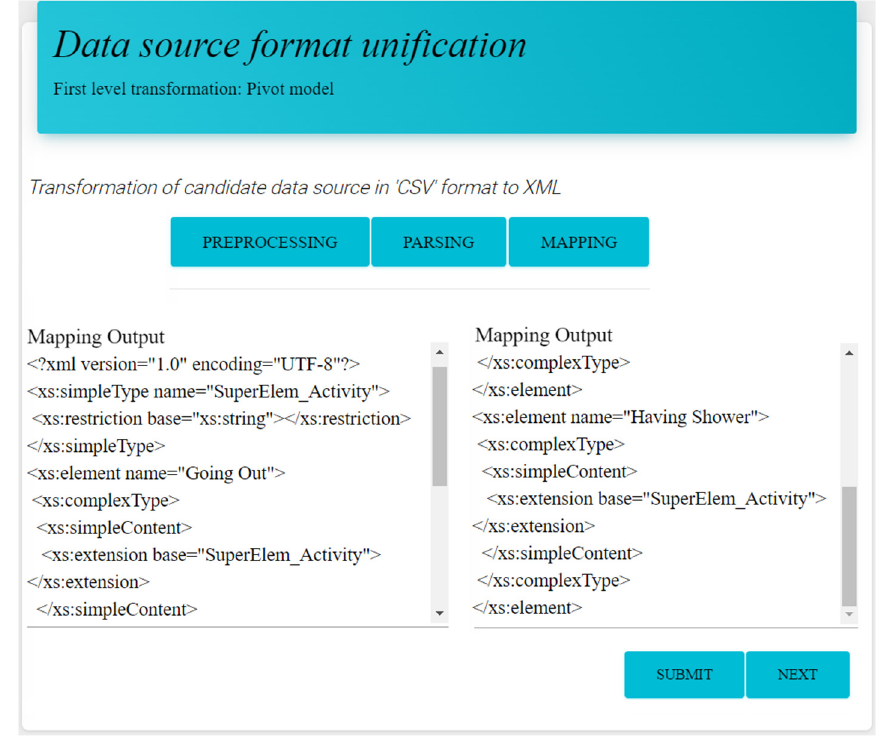
Figure 15. Data source format unification at 𝑡 (cid:2870) with an example of the XML schema (XSD).